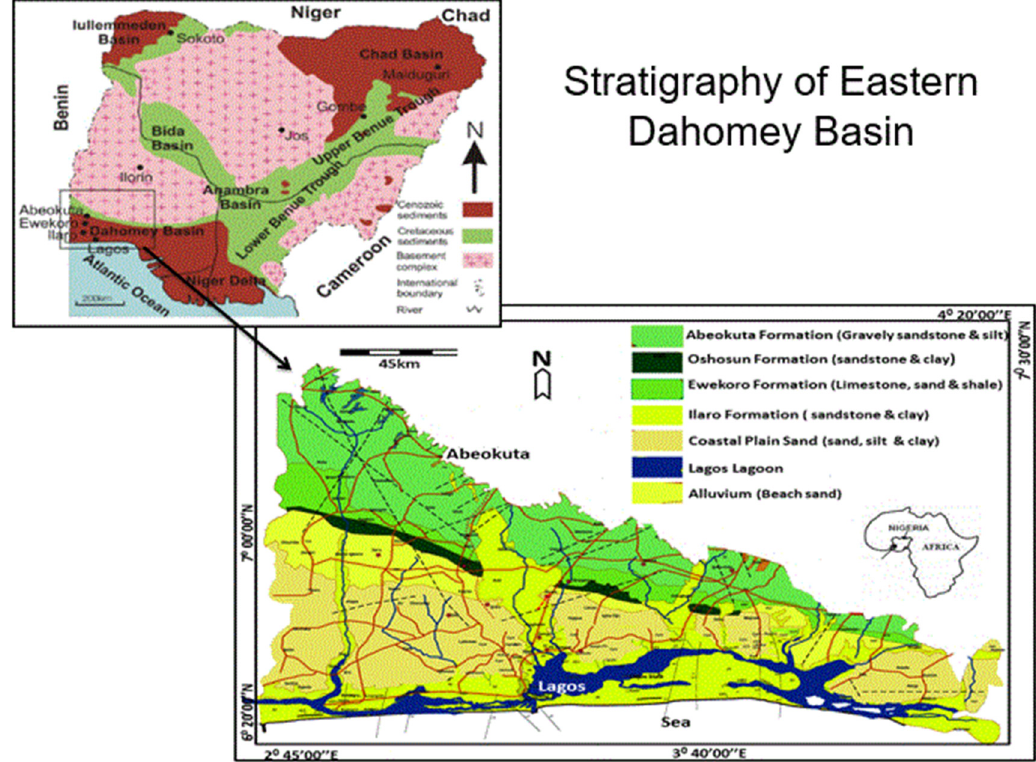
Figure 1. Map of Dahomey Basin showing rock types, stratigraphy succession, and location within Nigeria.